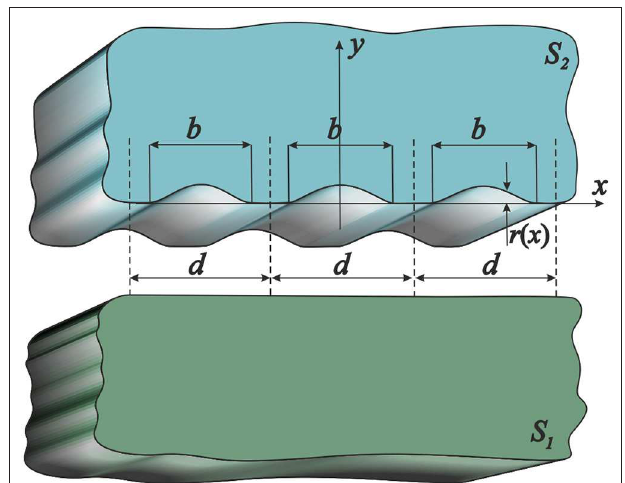
FIGURE 1 | The bodies prior to